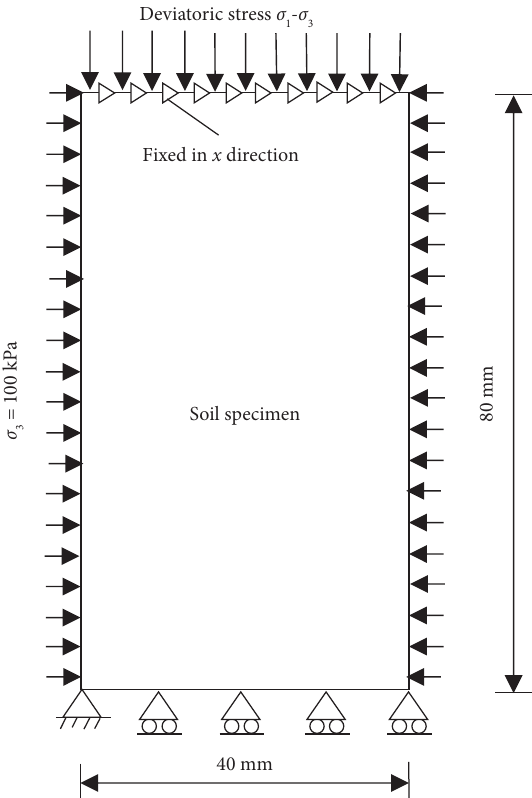
Figure 4: Geometry and boundary conditions for the biaxial